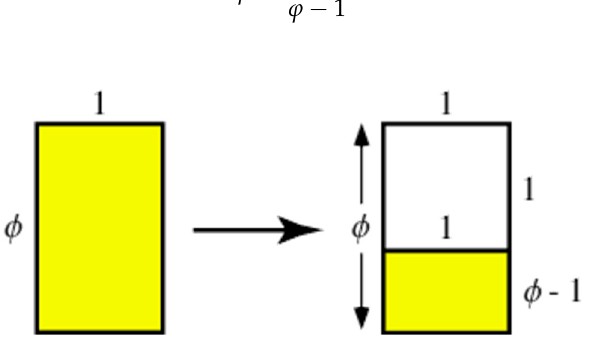
Figure 1. Pictorial representation of the golden ratio.